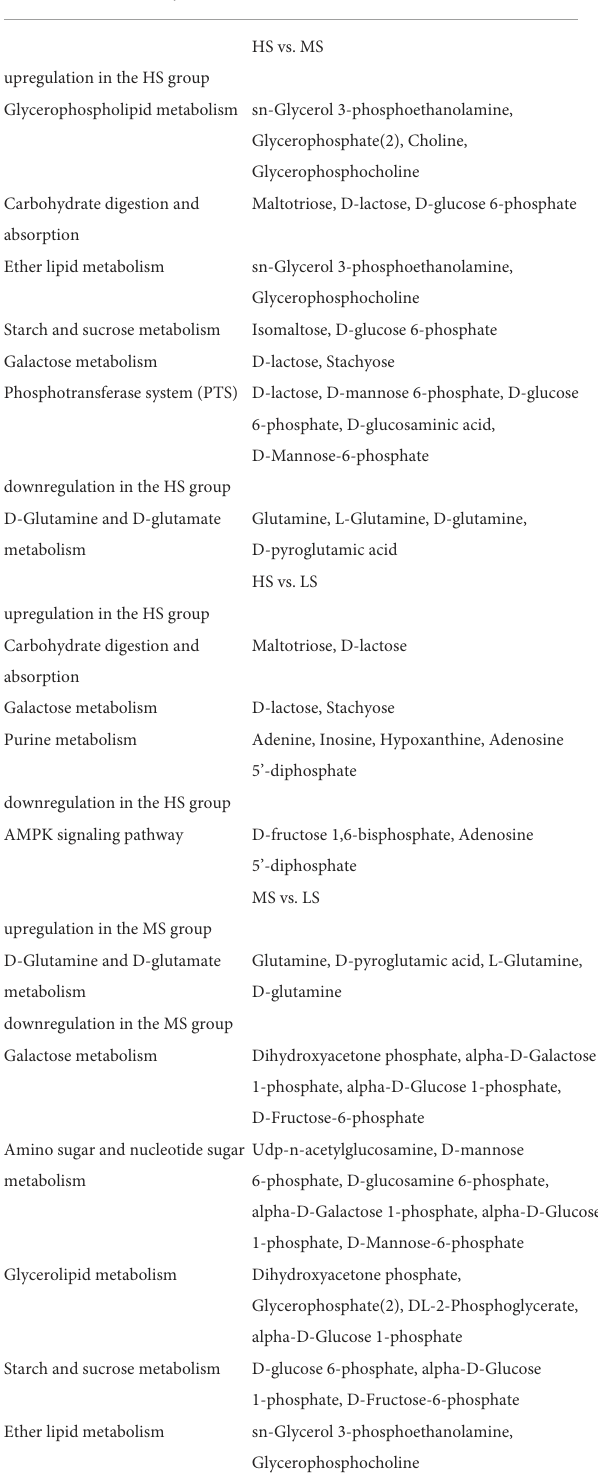
TABLE 7 Differential metabolites in the key metabolic pathways among the three comparisons (HS vs. MS; MS vs. LS; and MS vs. LS) in the longissimus lumborum of Tibetan sheep (accounting for the absolute value of differential abundance score ≥ 0.5).